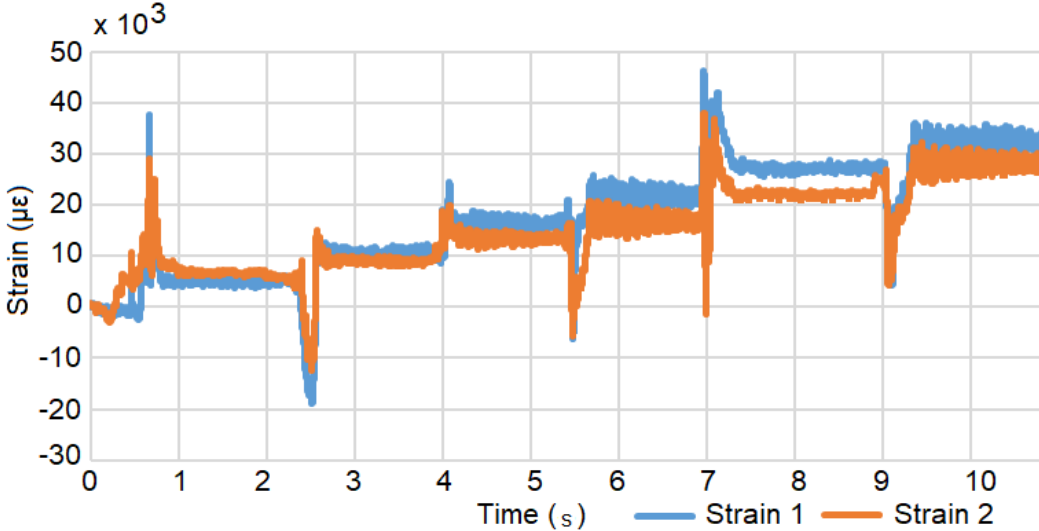
Figure 5. Strain versus time during the load test. The step response occurs when a weight is added.